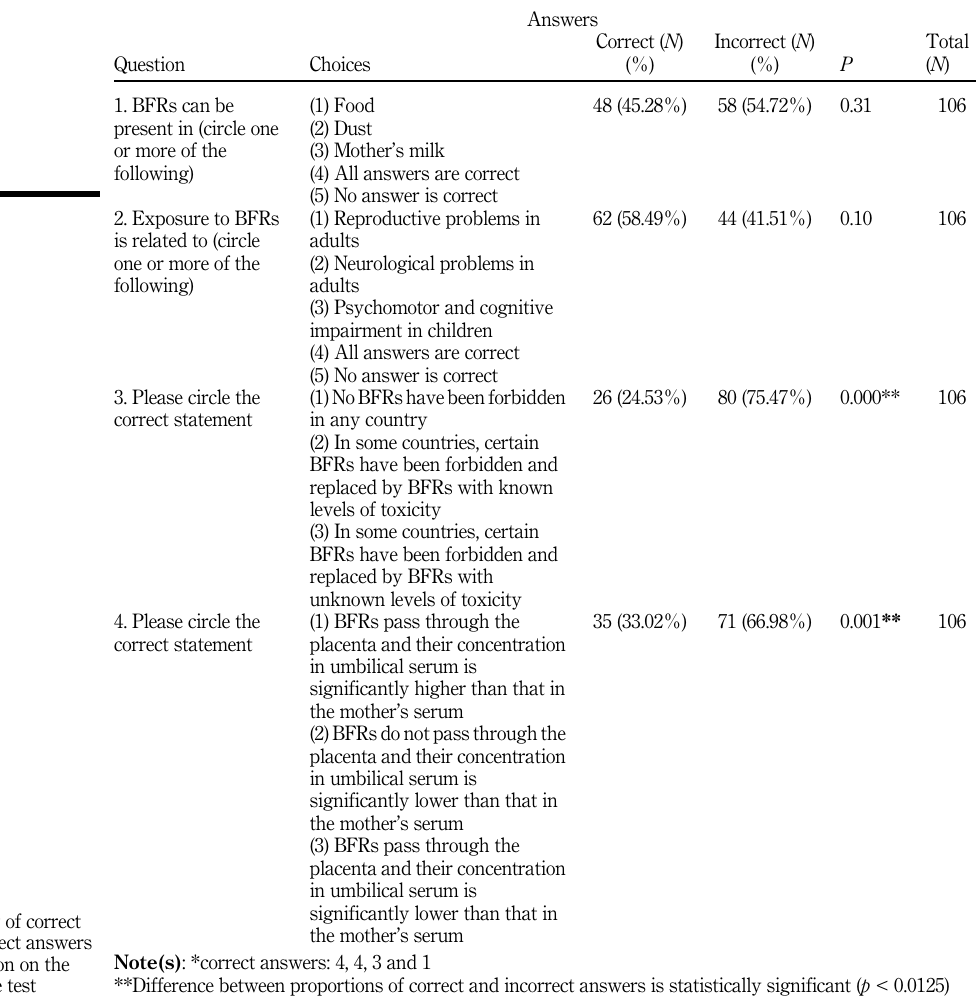
Table 3. Medians of participants ’ perceived responsibility of different sources to inform the general public about brominated flame retardants ’ health